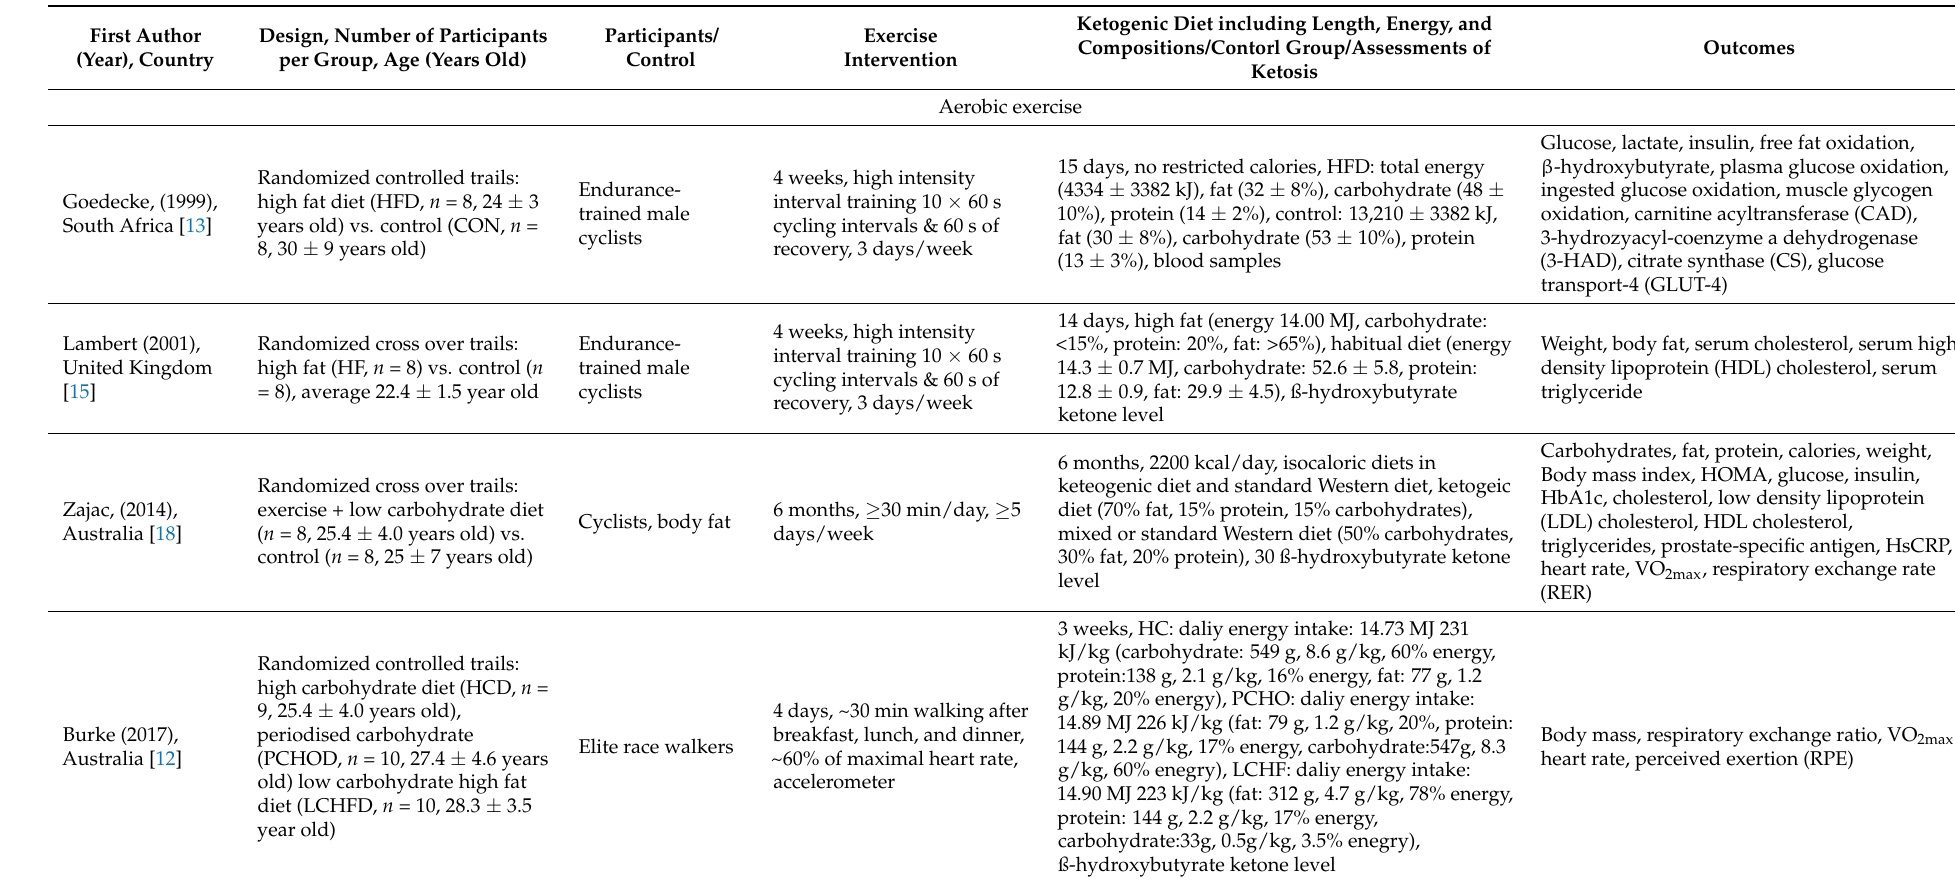
Table 1. Basic Characteristics of selected